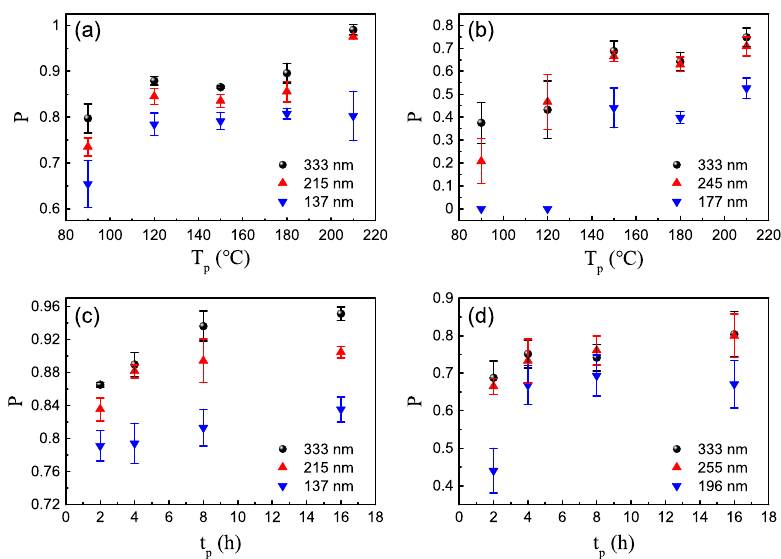
Figure 7. Dependence of the thermal stability parameter, P, on the pre-heat temperature, T p , ( a,b ) and the pre-heat time, t p , ( c,d ), for nano-domains with various sizes. Here, ( a , c ) are the results for the stripe domains, while ( b , d ) are the results for the dot domains. The pre-heat time, t p , was 2 hours for ( a , b ), while the pre-heat temperature, T p , was set to be 150 ◦ C for ( c , d ). All nano-domains were thermally annealed at T = 120 ◦ C for 1